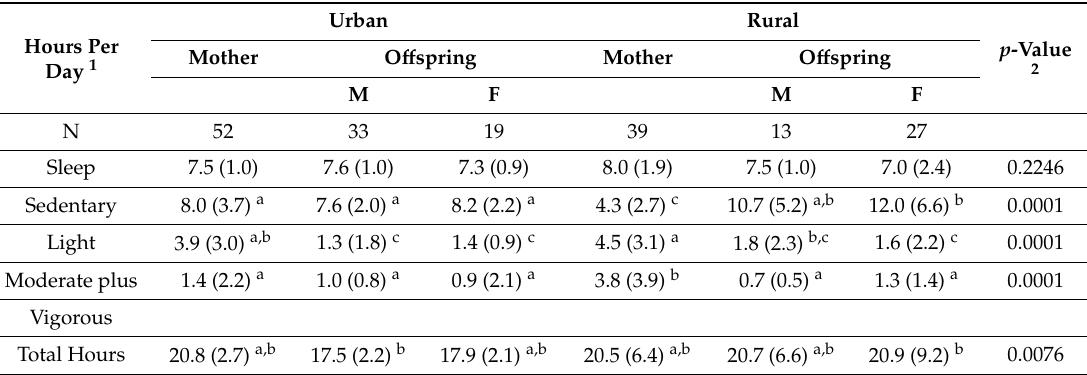
Table 5. Reported hours per day spent in di ff erent activity intensities by Chinese parents and o ff spring based on the CCFC Physical Activity Questionnaire.